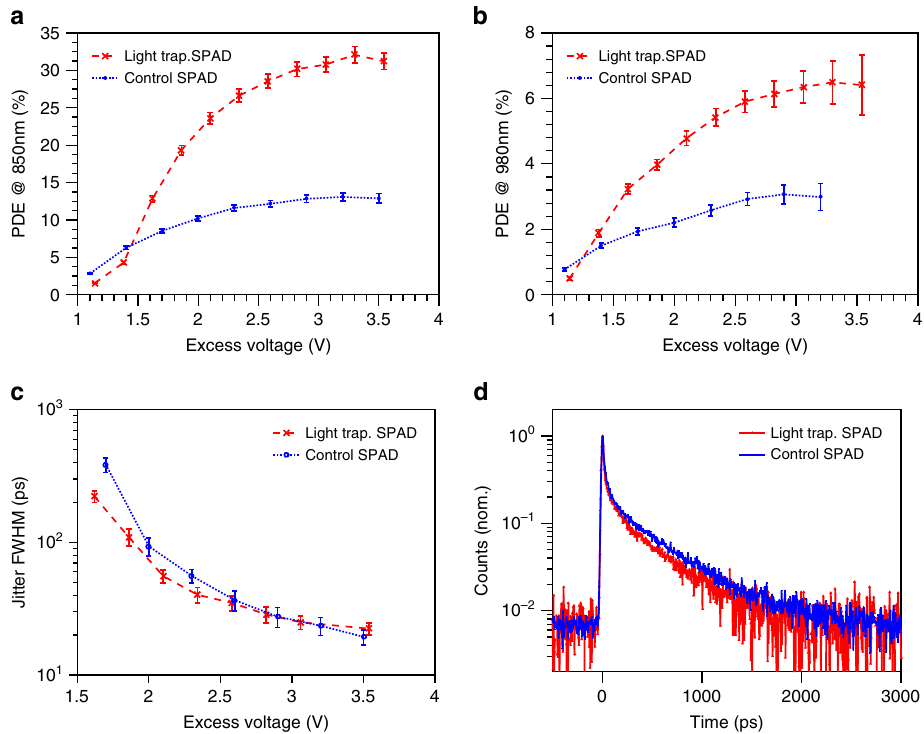
Fig. 4 Single photon measurements. In all fi gures, blue stands for control SPADs and red for light-trapping SPADs. The error bars in a – c are estimated measurement uncertainty (see Supplementary Notes 3 and 4 for uncertainty analysis). a PDE vs. excess voltage at 850 nm wavelength, error bar , s. d. b PDE vs. excess voltage at 980 nm wavelength, Error bar , s.d. c Jitter (FWHM) vs. excess voltage at 940 nm and 1 photon per pulse, error bar , s.d. d Jitter distribution of two SPADs at 940 nm wavelength with FWHM of 25 ps, measured at 1 photon per pulse and corrected for pile-up